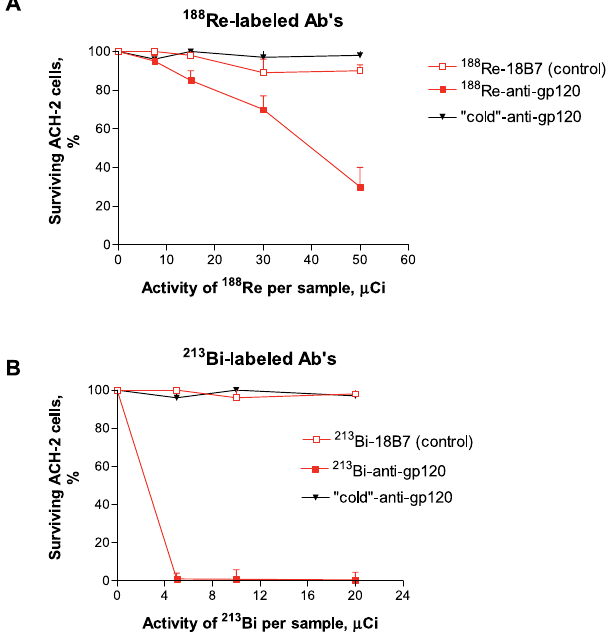
Figure 1. In Vitro Binding and Killing of ACH-2 Cells with 188 Re- and 213 Bi- Labeled Monoclonal Antibodies (A) ACH-2 cells treated with anti-gp120 labeled with 188 Re. The mAb 18B7 radiolabeled with 188 Re was used as a irrelevant control. (B) ACH-2 cells treated with anti-gp120 labeled with 213 Bi. The mAb 18B7 radiolabeled with 213 Bi was used as an irrelevant control. In both experiments the number of surviving cells was determined by Trypan blue dye exclusion. Samples were done in triplicate. Every data point represents the mean of three replicates and error bars show standard error of the